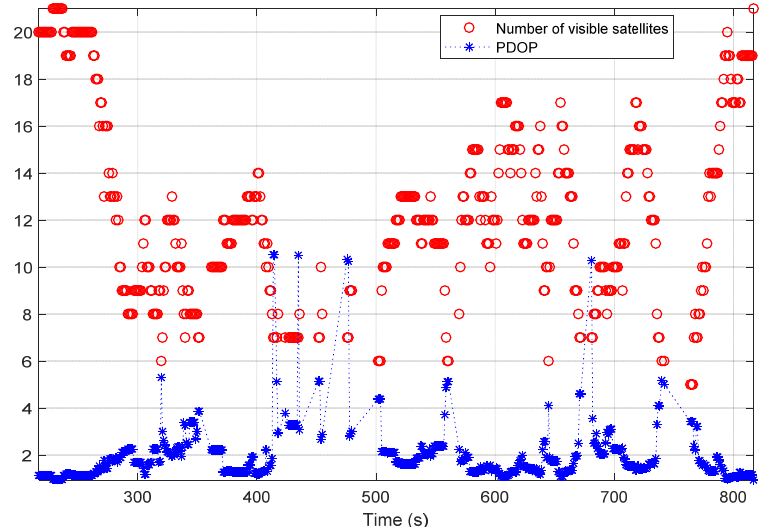
Figure 6. Number of visible satellites and position dilution of precision (PDOP) values in the first test.